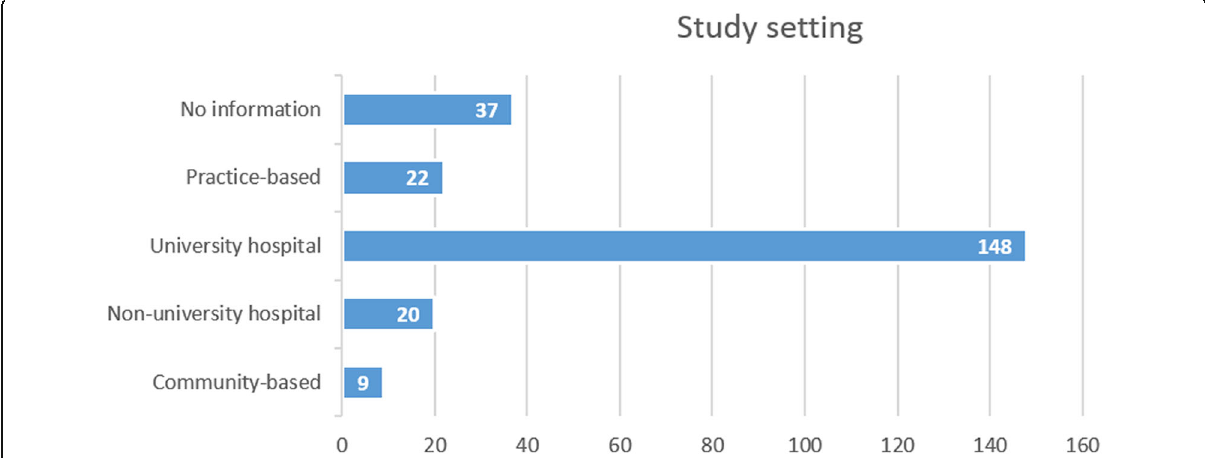
Fig. 3 Distribution of studies within each level of